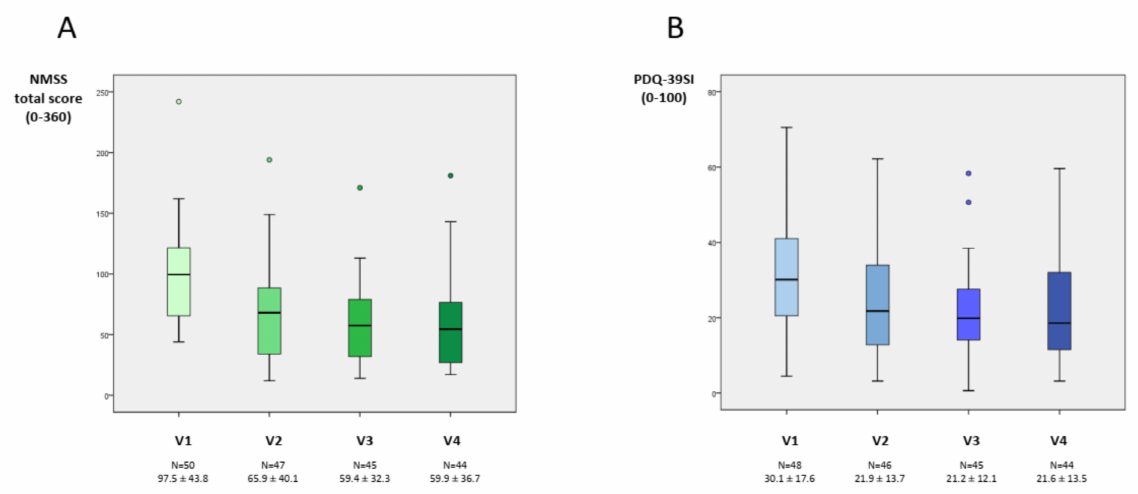
Figure 1. ( A ) NMSS total score at V1 (baseline), V2 (1 months ± 7 days), V3 (3 months ± 15 days) and V4 (6 months ± 15 days). Compared to the score at V1, the change at V2, V3 and V4 was significant ( p < 0.0001 for all analysis; V2 vs. V1; V3 vs. V1; V4 vs. V1). ( B ) PDQ-39SI at V1, V2, V3 and V4. Compared to the score at V1, the change at V2, V3 and V4 was significant ( p < 0.0001 for all analysis; V2 vs. V1; V3 vs. V1; V4 vs. V1). Data are presented as box plots, with the box representing the median and the two middle quartiles (25–75%). p values were computed using the Wilcoxon signed-rank test. Mild outliers (O) are data points that are more extreme than Q1–1.5 × IQR or Q3 + 1.5 × IQR. NMSs, Non-motor